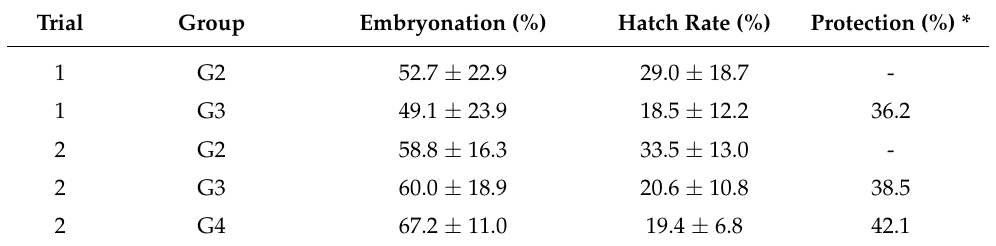
Table 4. Relative embryonation and hatch rate of eggs recovered from the gall bladder at